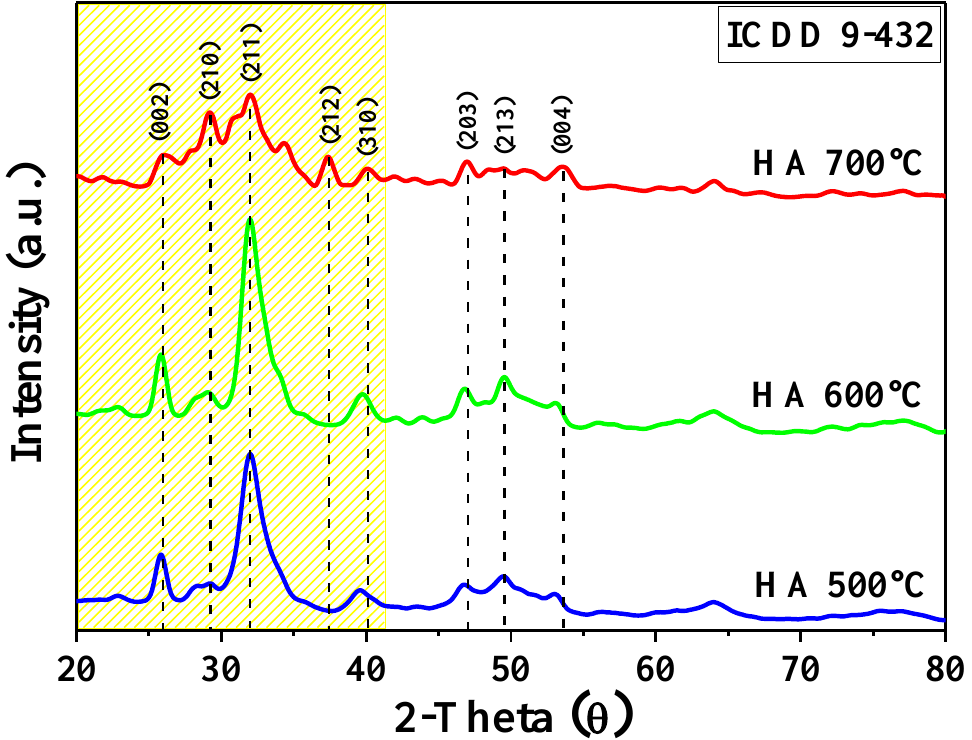
Figure 4. XRD spectra of the three HA samples synthesized at different temperatures.